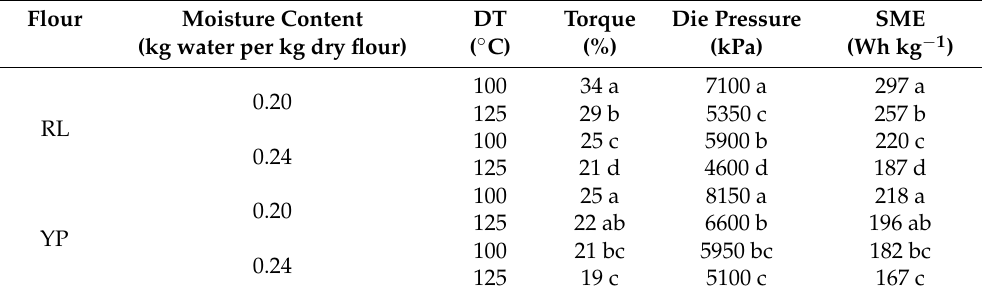
Table 1. Effects of feed moisture content and die temperature (DT) on torque, die pressure and specific mechanical energy (SME) values of extrudates made from red lentil (RL) and yellow pea (YP) flours. For each flour type, results in each column are significantly different if designated with different lowercase letters ( p ≤